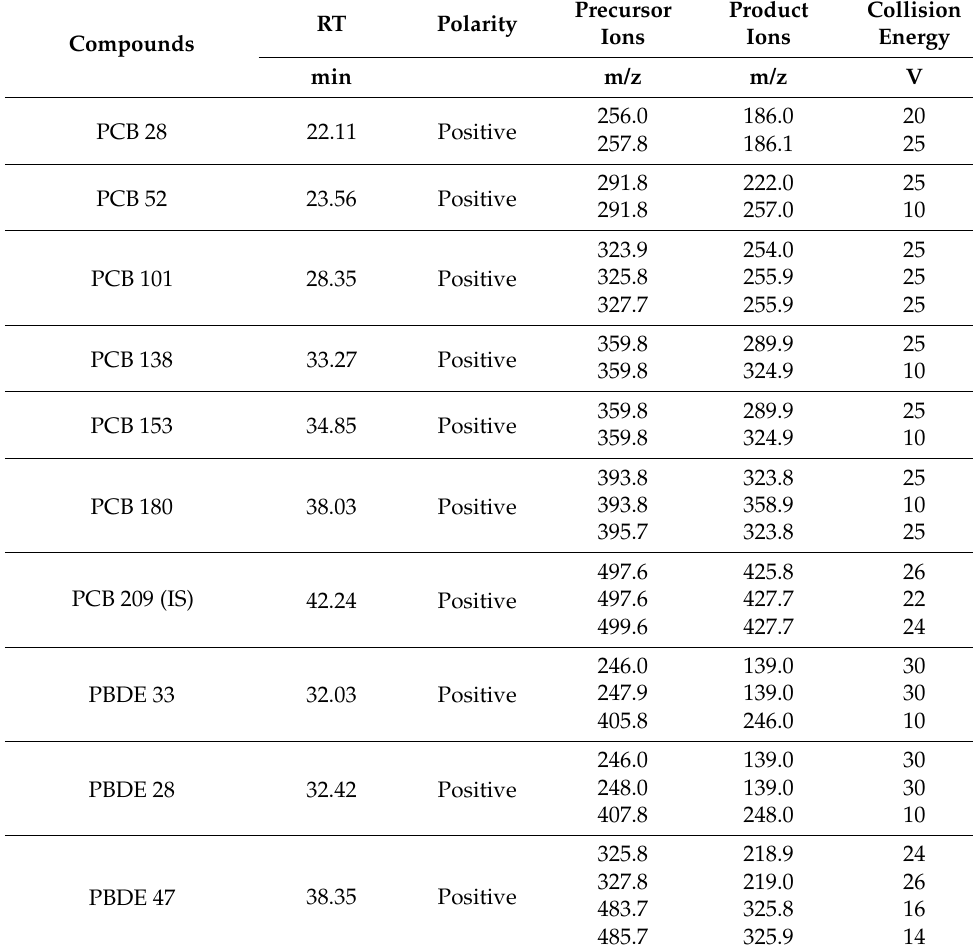
Table 2. List of the analysed compounds with their instrument parameters (retention time (RT), polarity, precursor ions, product ions, and collision